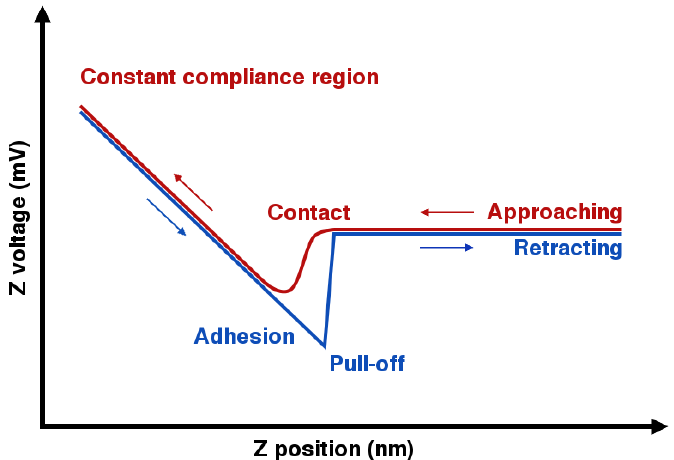
Figure 8. The measured voltage, which corresponds to cantilever deflection, decreases briefly at the moment of contact, before increasing with tip deflection while in constant contact with the sample. When retracting, the attractive intermolecular forces cause the tip to deflect toward the sample until reaching an adhesion threshold and releasing the cantilever back to